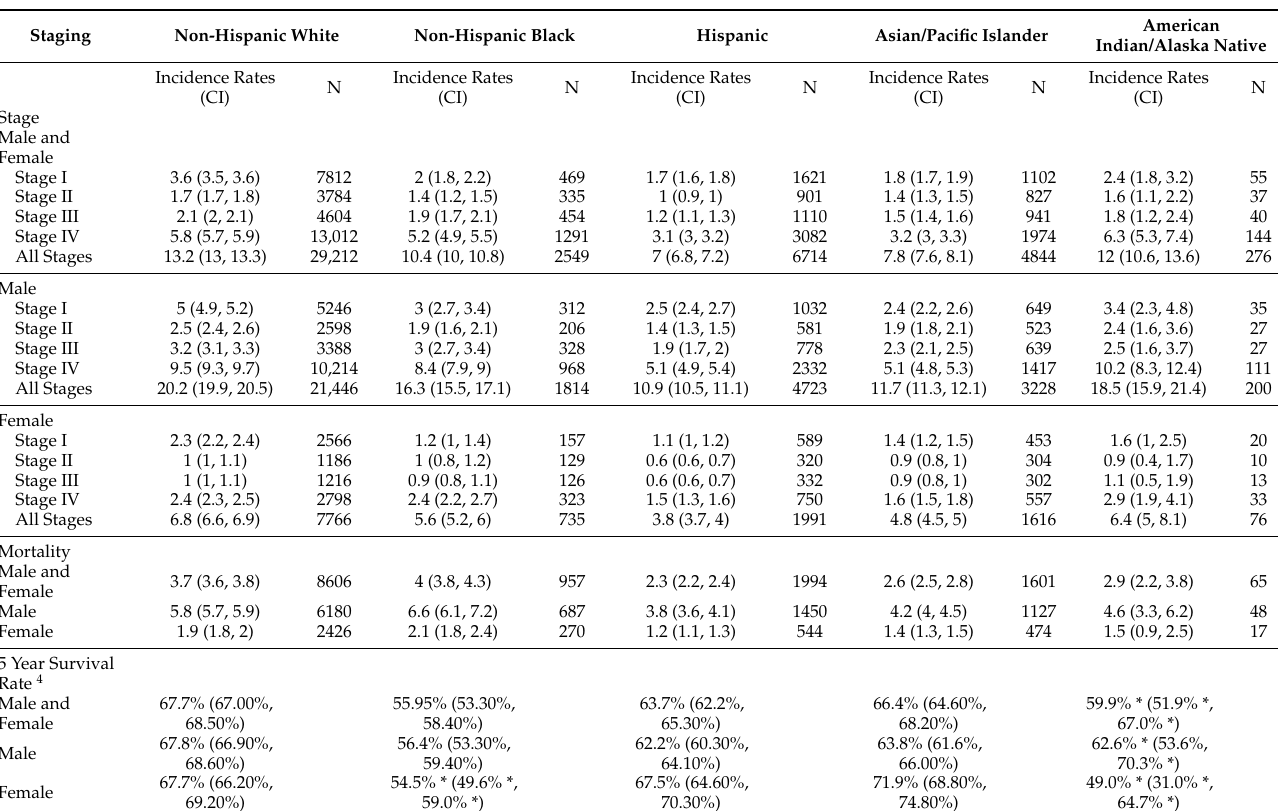
Table 2. Age-adjusted incidence rates 1 of head and neck cancers 2 , by race/ethnicity, stage at diagnosis, 5-year survival rate 3 , and sex, 2009–2018